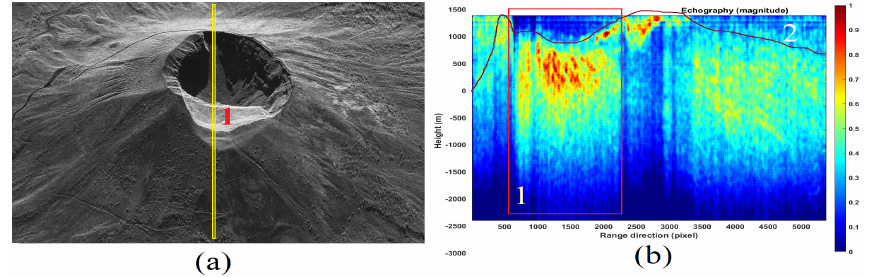
Figure 8. Range-line echographic tomography result (magnitude). ( a ) SLC SAR image (in magnitude). ( b ) Tomographic result (in magnitude). The yellow tomographic line is indicated by the number 1.